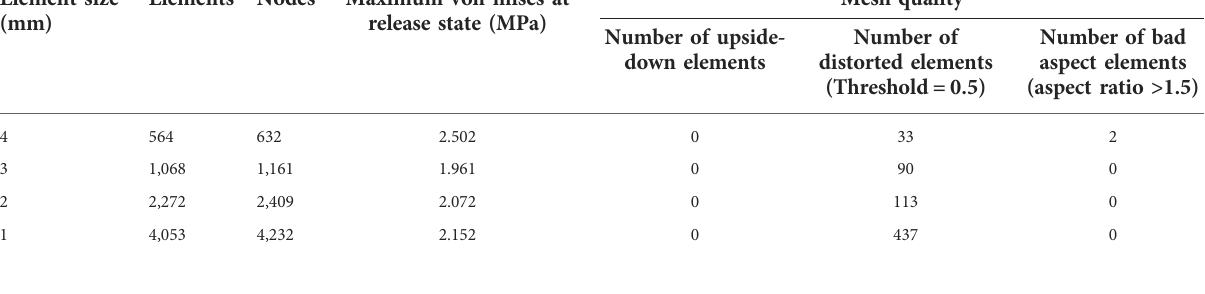
TABLE 2 Von Mises and mesh quality of A-T fl ap FE models with different element sizes. Element size